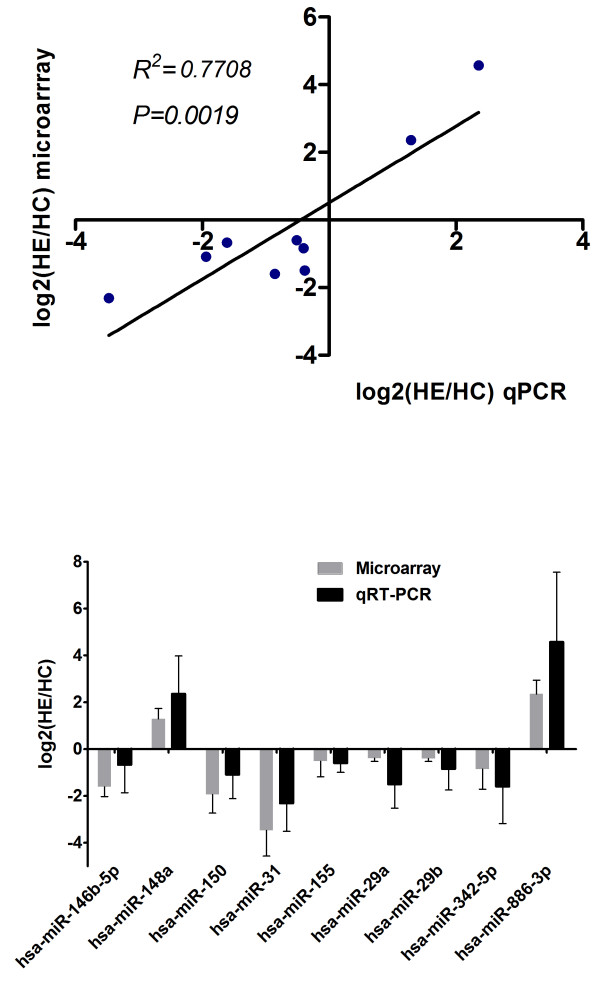
Comparison of miRNA expression levels obtained by miRNA microarray and Taqman qRT-PCR analysis.